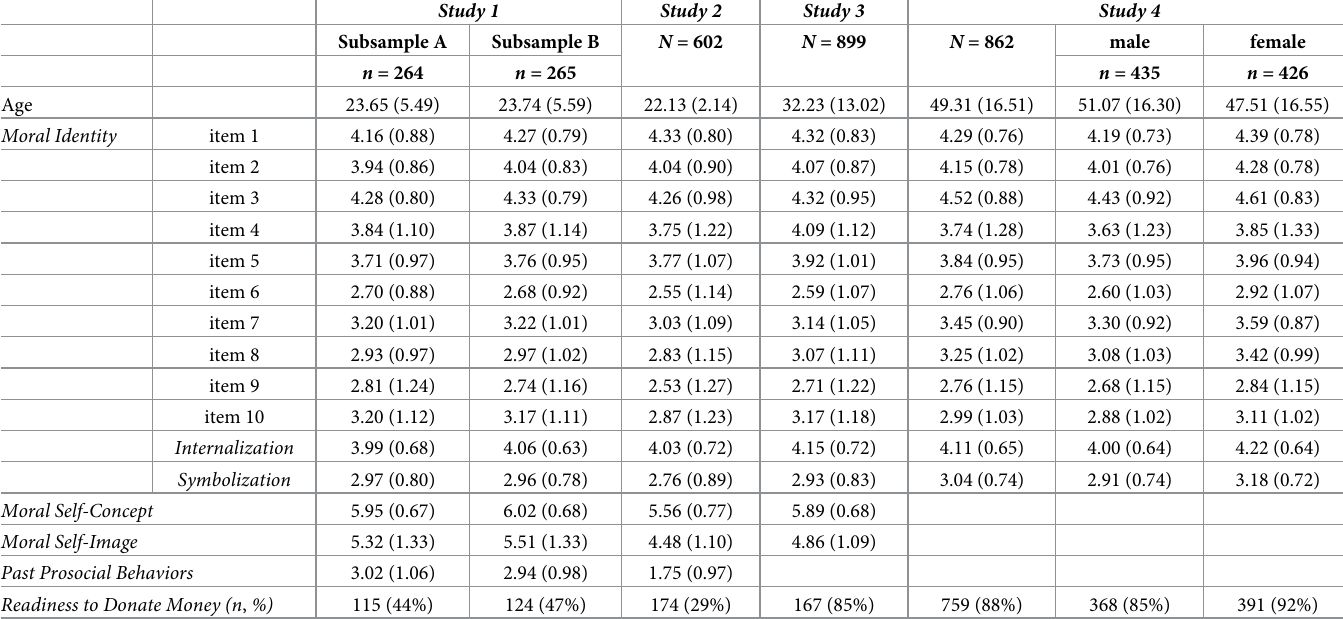
Table 1. Means and standard deviations of SMIS, MSCS, MSIS, PPB and RDM in Studies 1, 2, 3 and